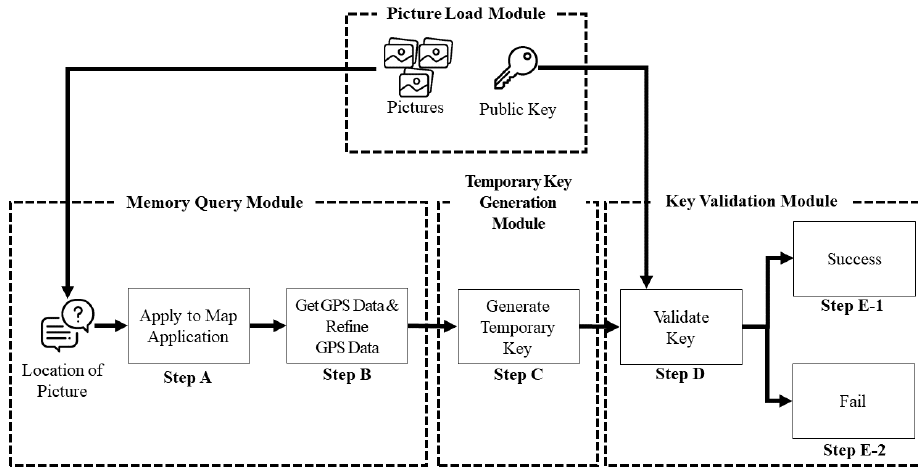
Figure 4. Private Key Recovery